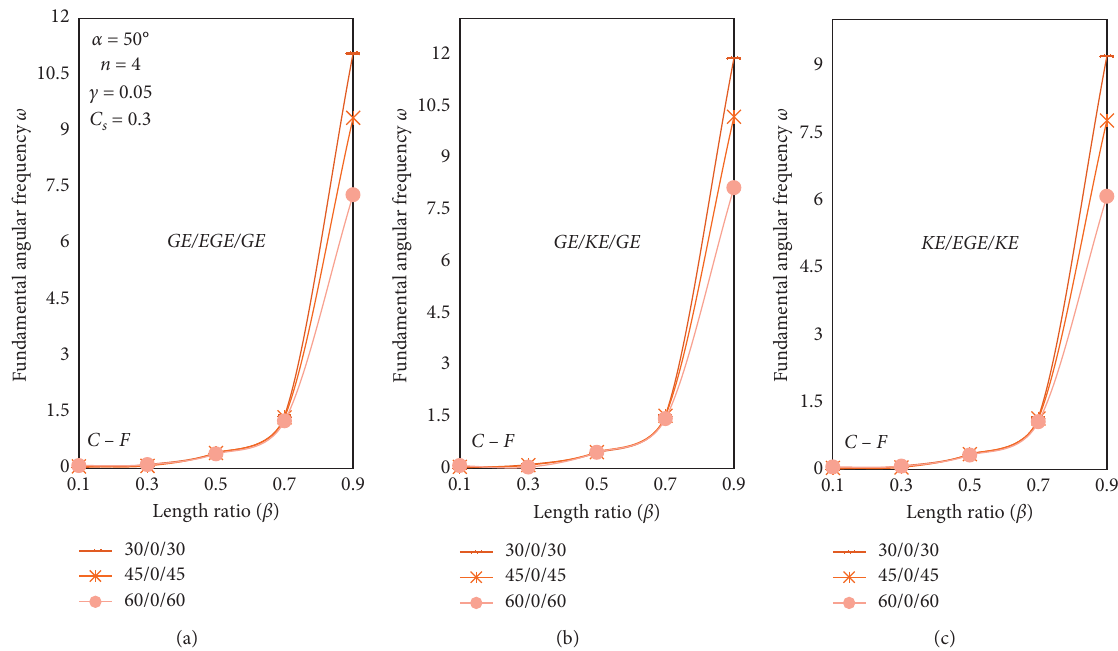
Figure 13: Influence of length ratio on the fundamental angular frequency of five-layered conical shells with different material combinations.